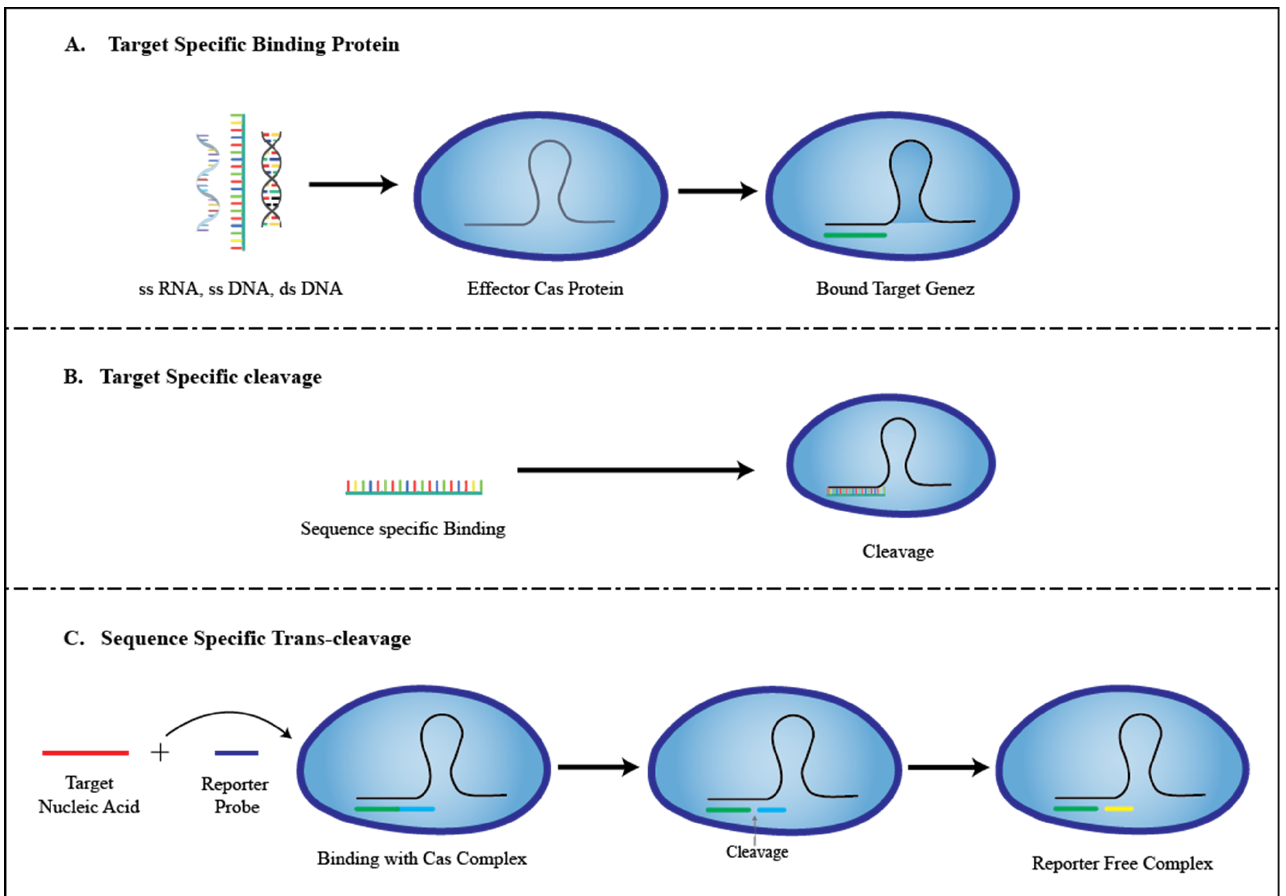
Figure 1. Step mechanism used by the CRISPR-Cas system to identify, isolate, and/or knockout a gene sequence. ( A ) Target-specific binding: The process of acquiring a spacer starts with Cas1 and Cas2 recognizing the invasive DNA and cleaving a protospacer. In order to replicate the direct repeat and repair the CRISPR, the protospacer is ligated to the direct repeat next to the leader sequence. The Cas protein that is catalytically inactive is bent to the target gene, which is complementary to gRNA. ( B ) Biogenesis and target-specific cleavage: The CRISPR sequence must be converted into CRISPR-RNA (crRNA), which later directs the Cas nuclease to the target during the interference stage. The crRNA is first produced as a single lengthy transcript that covers the majority of the CRISPR array. The Cas proteins then split this transcript into crRNAs. The way that different CRISPR-Cas systems create crRNAs varies. The target gene is cleaved by Cas proteins thatare followed by sequence-specific binding. ( C ) Sequence-specific trans cleavage: The Cas protein non-specifically cleaves the ssDNA or ssRNA upon binding to the target gene, thereby freeing the reporter probe.